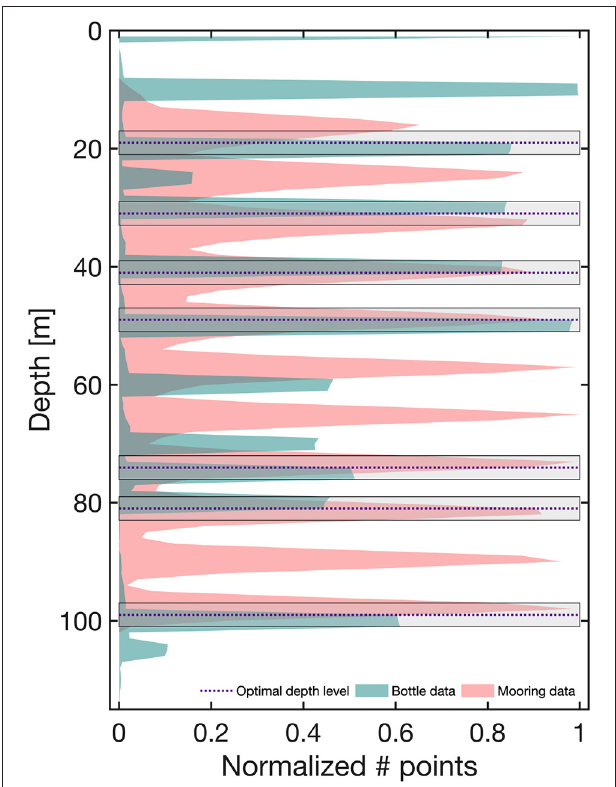
FIGURE 3 | The total number of bottle and Mooring data points per 1 ± 2 m depth bin at the NRSPHB/PH100 site, normalized using the maximum number of data points available in a depth bin for the corresponding data source. This is accompanied by the chosen optimal depths with the corresponding depth bin margins (black